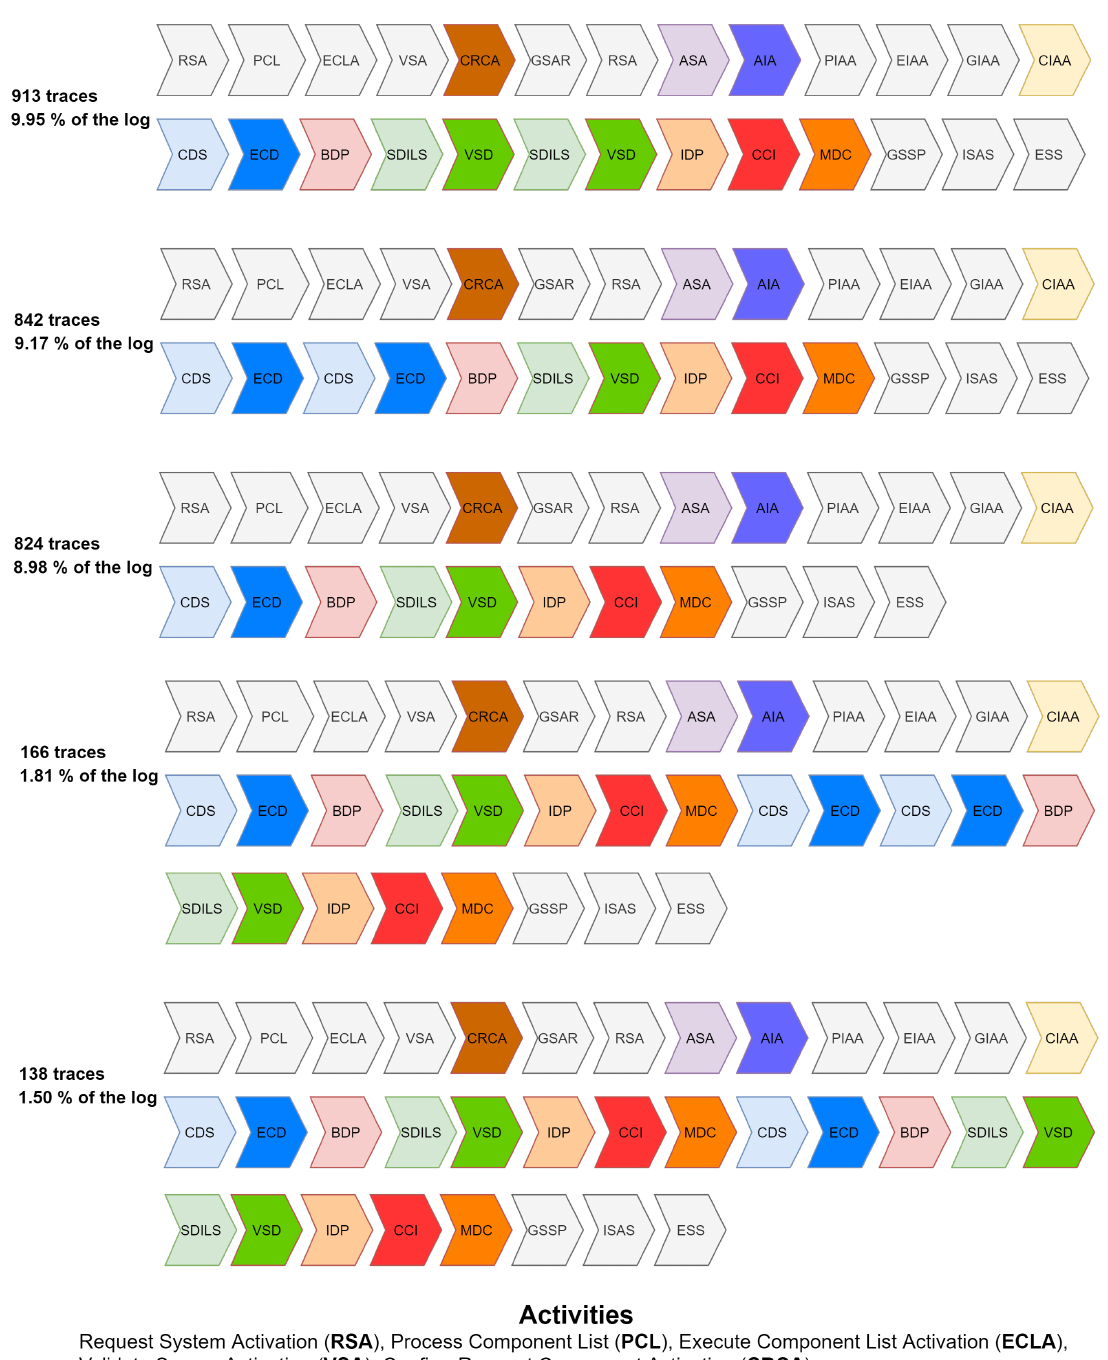
Figure 3. Top five process variants contained in the IoT Air Quality Monitor event